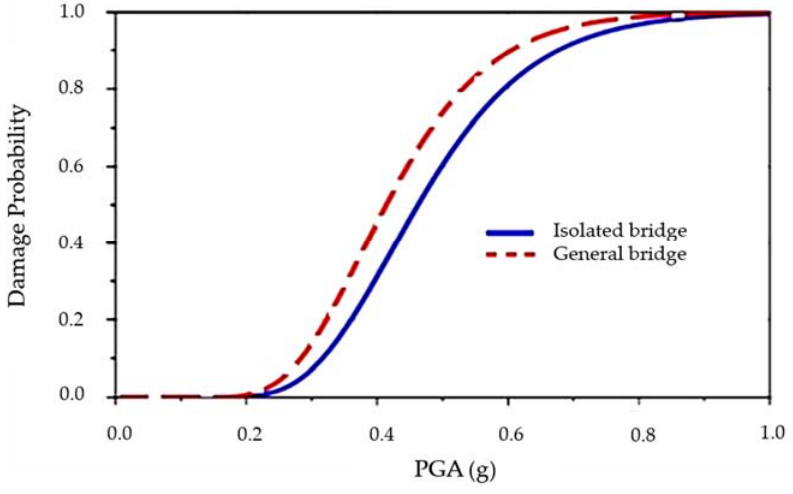
Figure 7. The seismic fragility curves of the girder collision (general bridge and isolated bridge).